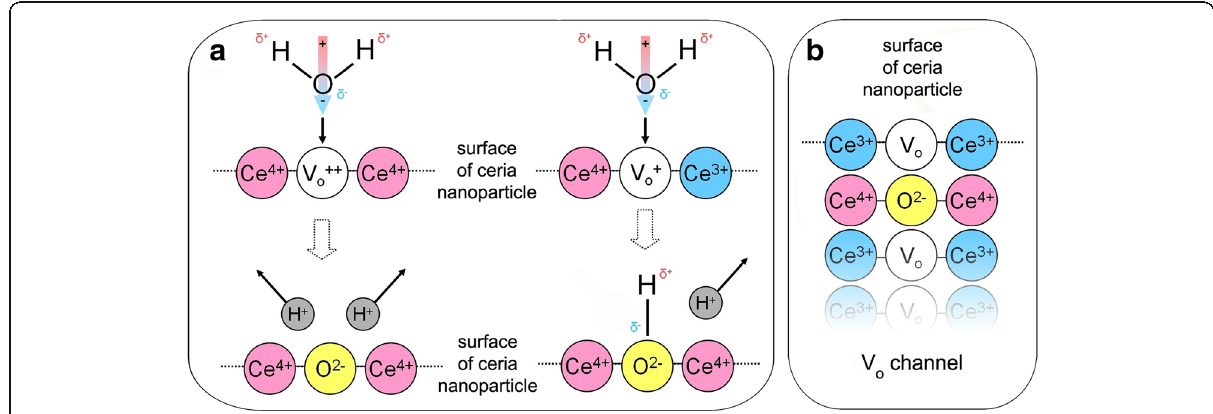
– Ce 4+ site and single-oxidized O – Ce 3+ site for next oxidation 3+ – V O